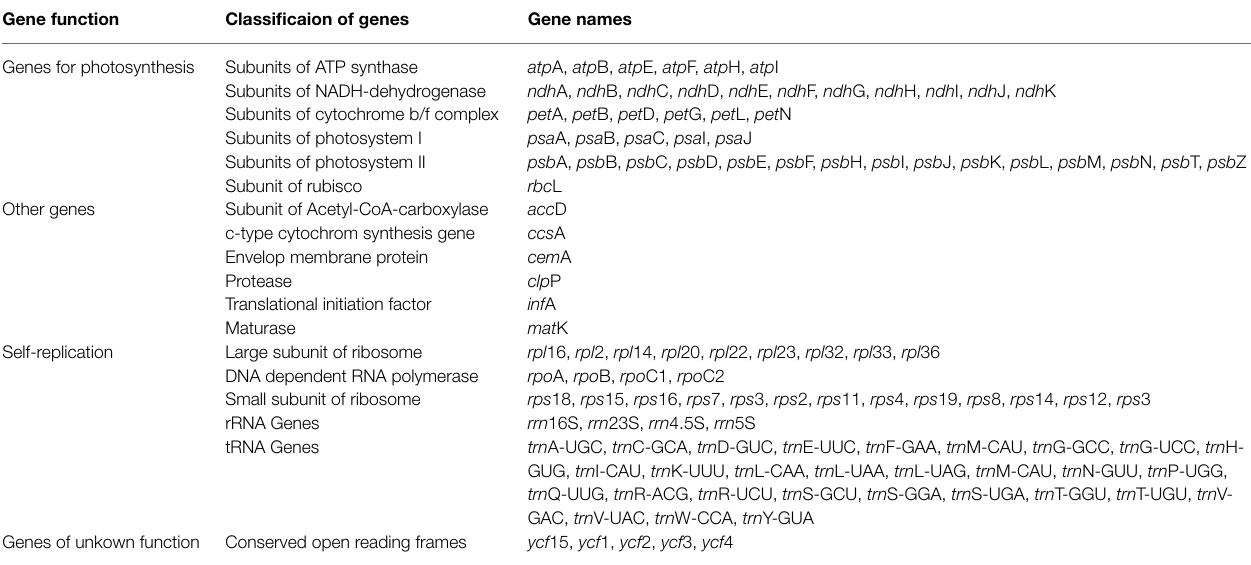
TABLE 2 | Gene contents in the chloroplast genomes of C. vaginatum , L. sinense , and L. jeholense